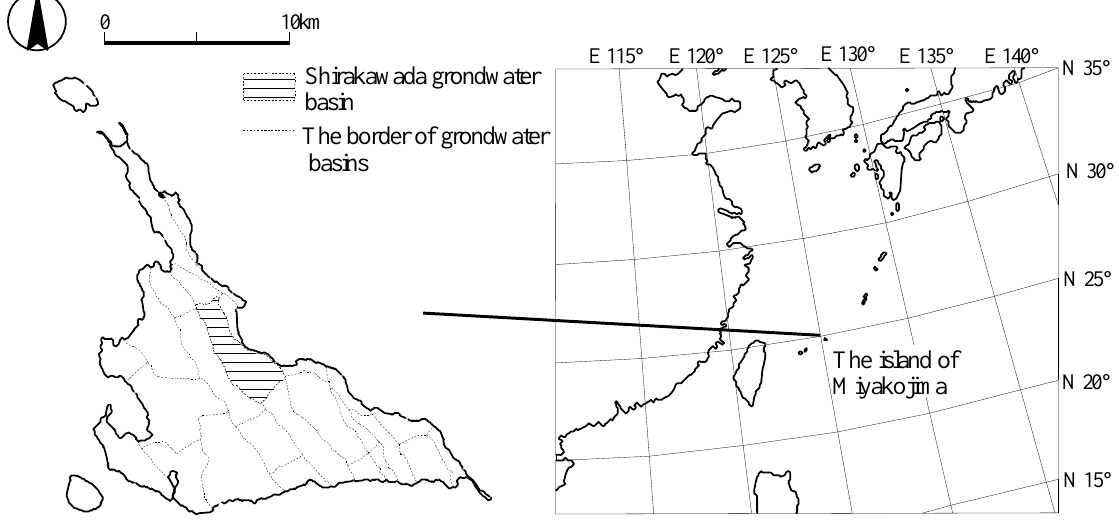
Figure 1. Groundwater basins on the island of